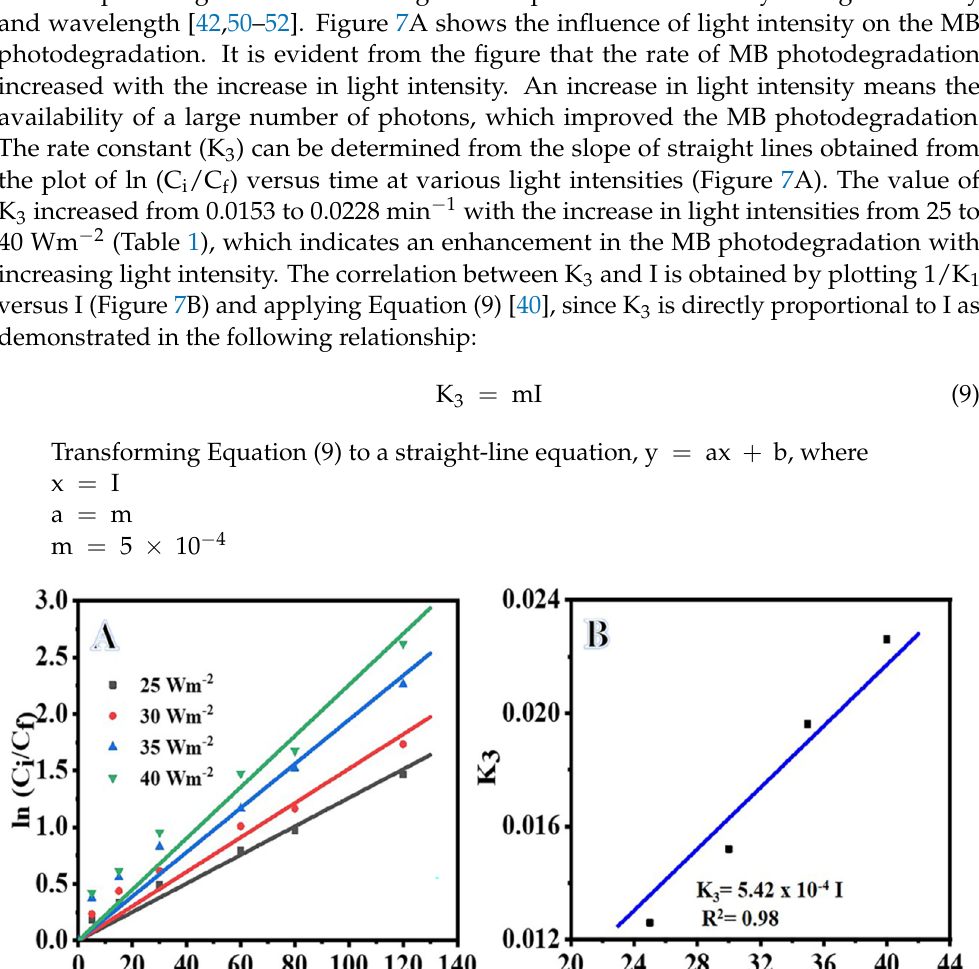
Figure 6. Influence of reaction temperature on photodegradation of MB ( A ), ln Ci/Cf vs. time ( B ), Arrhenius plot for MB photodegradation. The parameters are: photocatalyst amount = 0.2 gm L − 1 , C i = 0.1 M, and I = 25 W m − 2 .